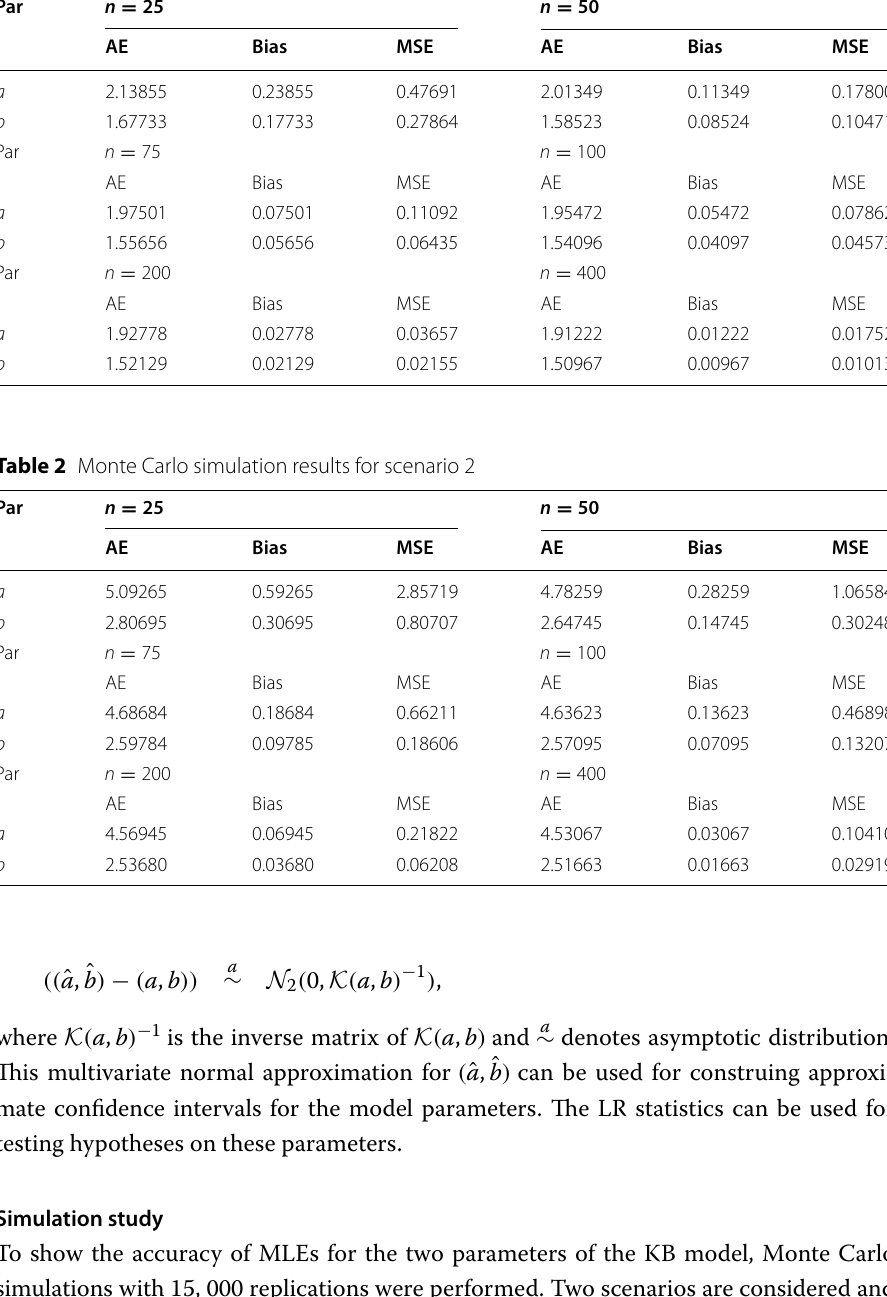
Table 1 Monte Carlo simulation results for scenario 1 Par